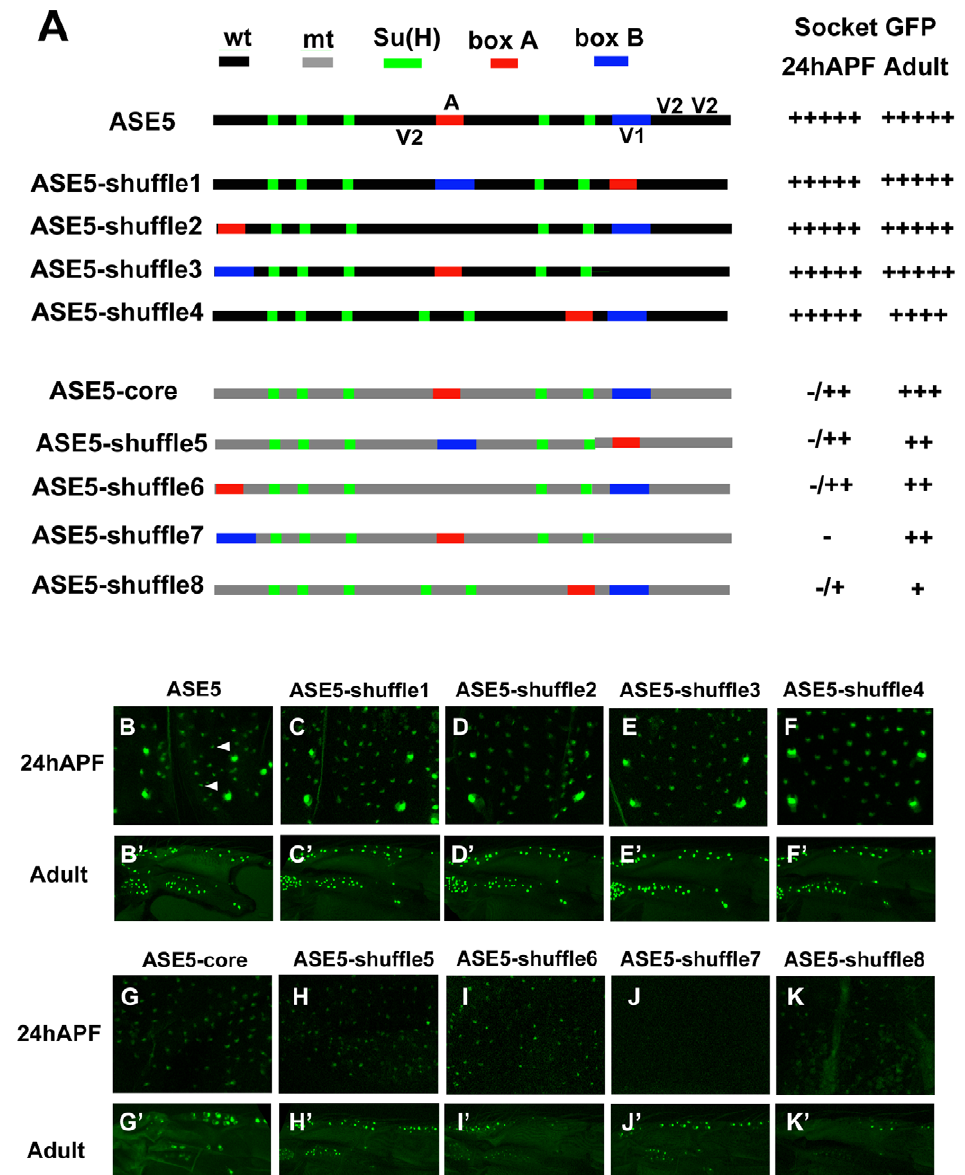
Figure 2. Rearrangement of required sequence elements has little effect on the activity of ASE5. (A) Diagrams of ASE5-GFP reporter gene constructs in the ‘‘shuffle’’ series. The five Su(H) binding sites are marked in green; box A (see text) is in red; box B is in blue. Other wild-type (wt) sequences are shown in black, while mutant (mt) sequence (see Materials and Methods) is marked in gray. All constructs are of the same size as wild- type ASE5; the positions of the box A and box B elements are exchanged with those of similar-sized segments elsewhere in the module. ASE5- shuffle1–4 retain wild-type sequences of ASE5, while ASE5-shuffle5–8 bear mutated sequences between the Su(H) sites, box A, and box B. Observed levels of GFP expression in socket cells are summarized at right. Wild-type ASE5 is scored as very strong ( +++++ ); other constructs vary from very strong to moderate ( +++ ) to very weak ( + ). Constructs that fail to drive detectable GFP expression are indicated as negative ( 2 ). (B–K, B 9 –K 9 ) Effects of motif rearrangements on the activity of ASE5 are examined in nascent socket cells of notum microchaetes at 24 hours APF (B–K; see arrowheads in